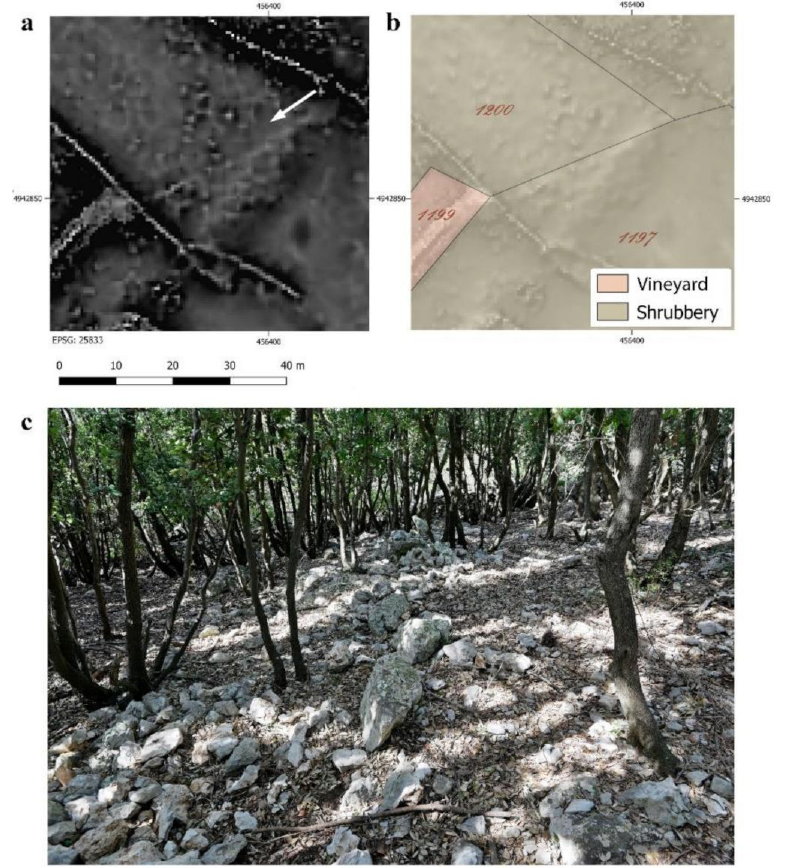
Figure 30. The wall indicated as a white linear signature in the pOp(10) visualization ( a ) must be of older date as it is marked on the transcription of the 1821 Franciscan Cadastral Map (source: Archivio di Stato di Trieste—Catasto franceschino/Distretto di Cherso/Comune di Punta Croce/mappa XVI, unit à archivistica 383 b 14) from ( b ) and is stratigraphically older than the enclosure wall (Figure 31). ( c ) Remains of the dry stone wall as observed on site (Photo: M. Doneus, 13 April